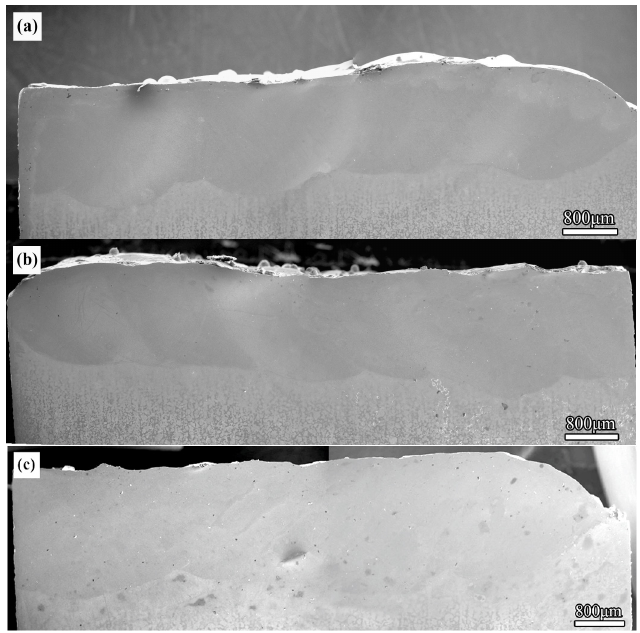
Figure 1. Cross section of the laser cladded Fe-based coatings at low magnification ( a ) S1; ( b ) S2; ( c ) S3.